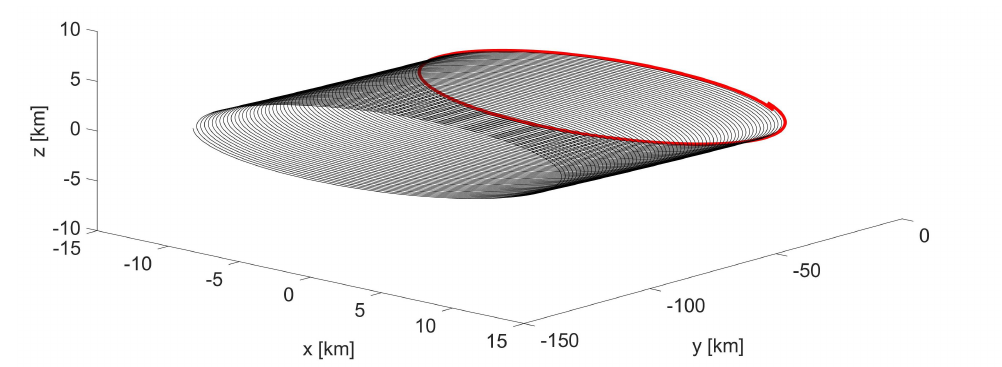
Figure 12. Lunar formation: trajectory (black) in F r resulting from non-invariant initial conditions; the first orbit is plotted in red.